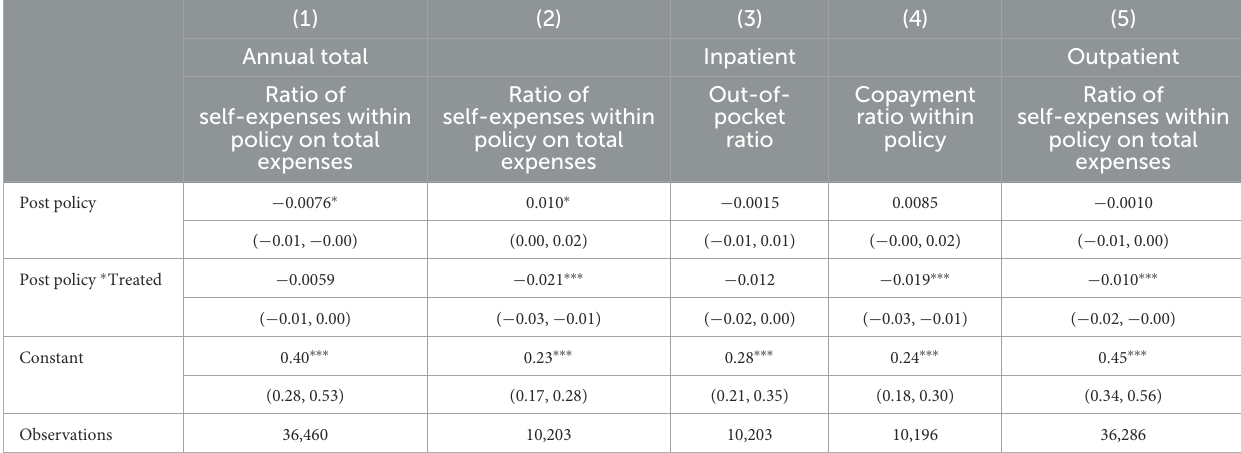
TABLE 6 DID regression analysis of the effect of policy change on annual cost-sharing ratios.